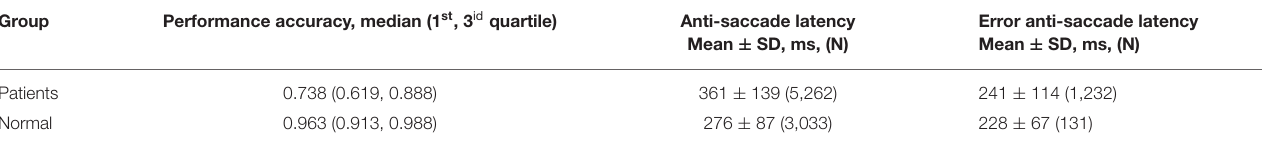
TABLE 2 | Oculomotor parameters from anti-saccade task